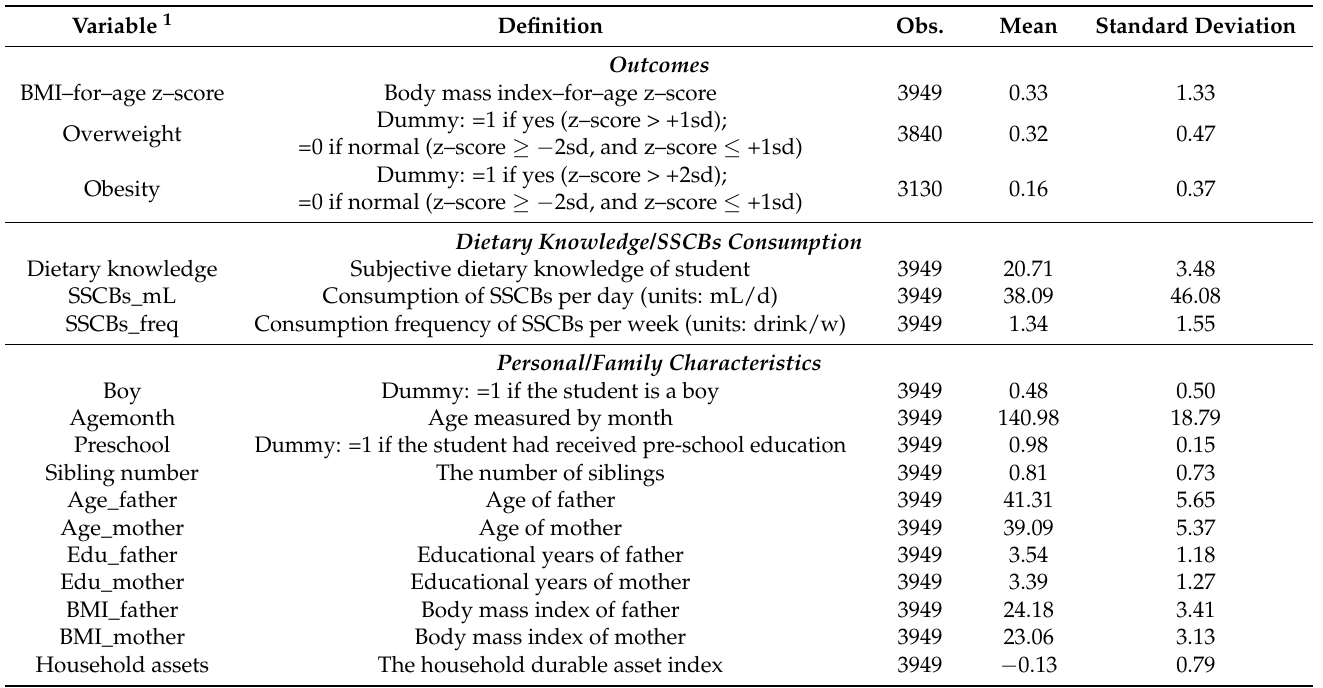
Table 2. Statistics of dependent variables, independent variables, and control